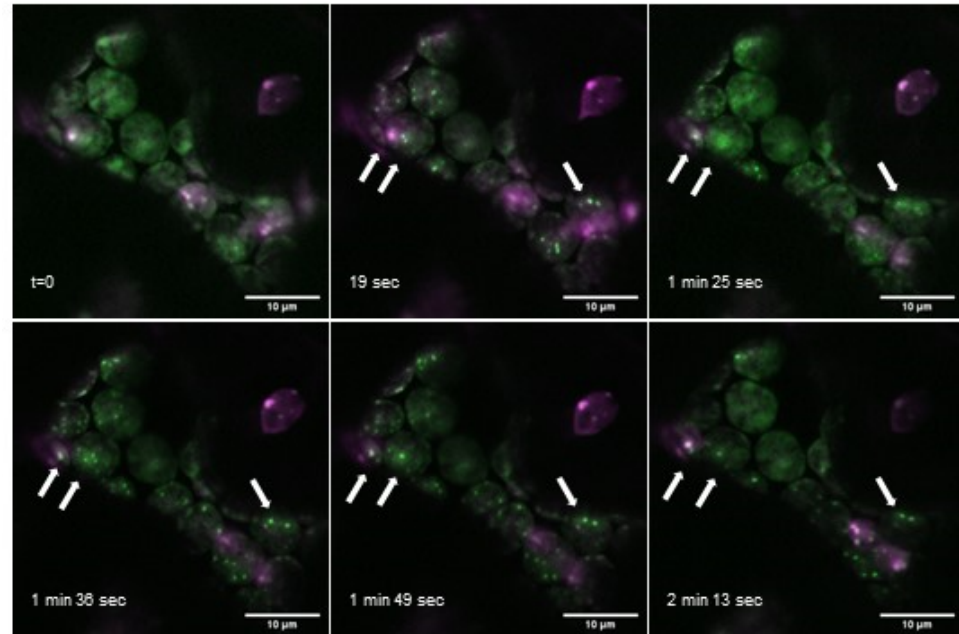
Figure 5. Appearance of PII foci over time. Overlay images of time series of At PII-GFP (green) and At NAGK-mCherry (magenta), both expressed under the control of p35S, 2 days after transient transformation of N. benthamiana. White arrows mark exemplarily PII foci observable over the whole time range. Scale bar: 10 µm.